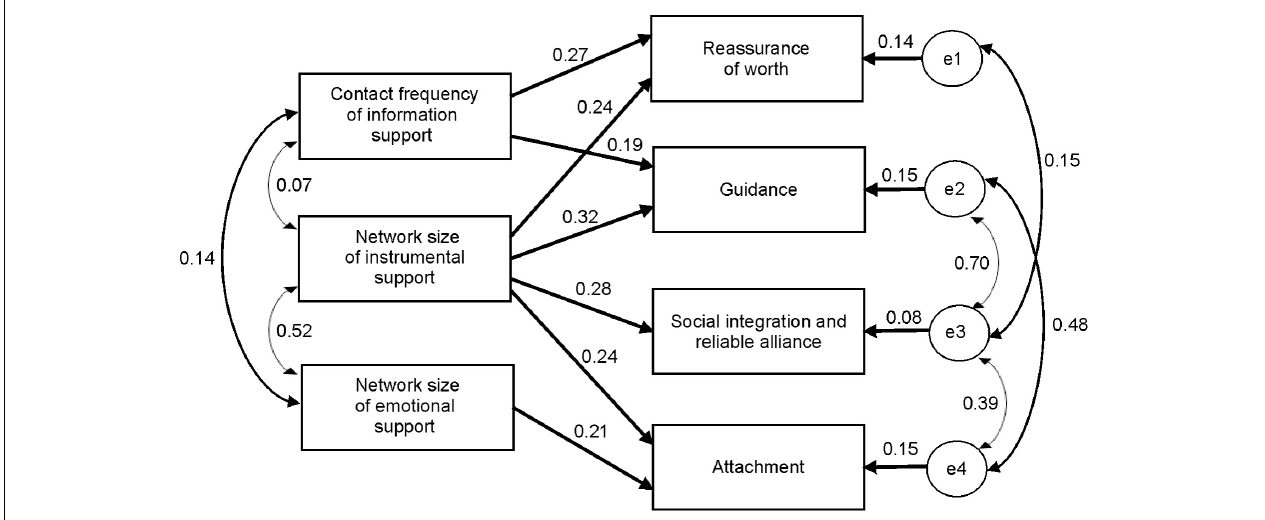
FIGURE 4 | Path analysis of the influence pattern of social support network on perceived social